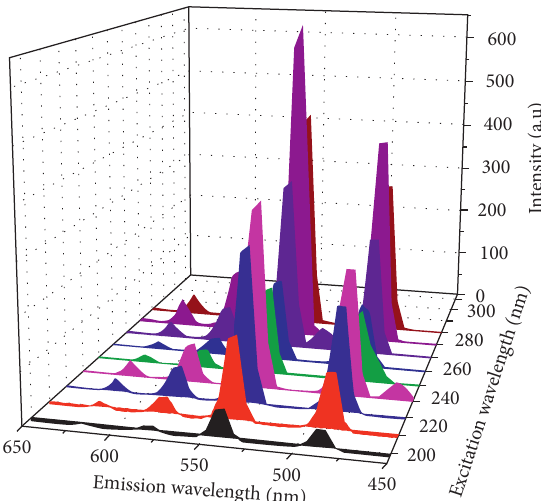
Figure 1: Excitation and emission spectra of 1 (24mg/L) in Tris-HCl buffer (pH 7.4). Table 3: Luminescence properties of the pyridinedicarboxylate-Tb(III) complexes (24mg/L) in Tris-HCl buffer (pH 7.4). Complex λ ex (nm)